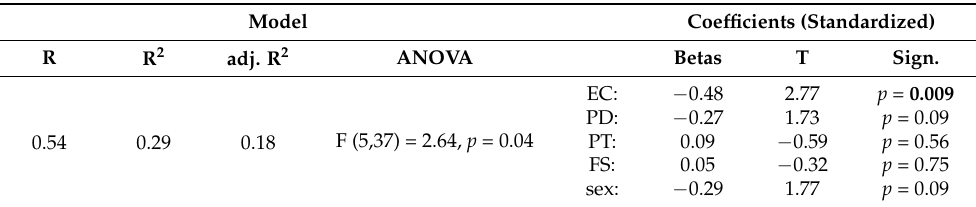
Table 2. Regression analyses of prosocial acting with empathy subscales as predictors. Significant values in